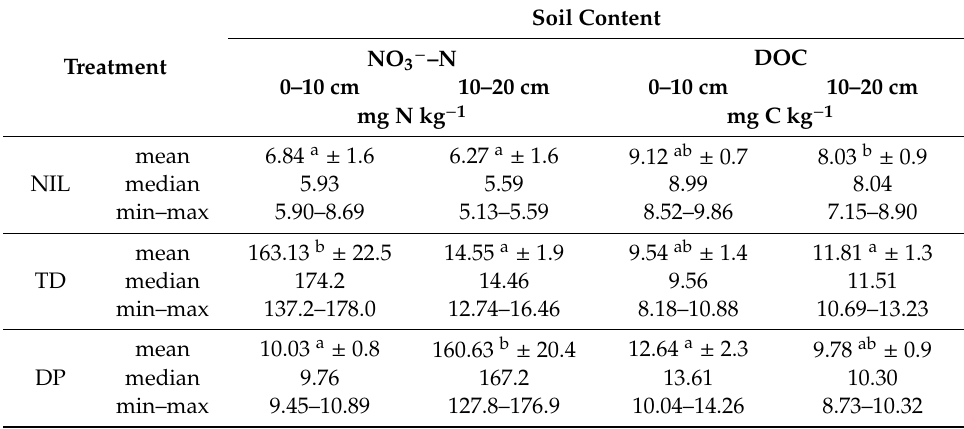
Table 2. E ff ect of di ff erent NH 4 NO 3 applications: top dressing (TD) and deep placement (DP) on the content of NO 3 − –N and dissolved organic carbon (DOC) in the soil at the end of study period.